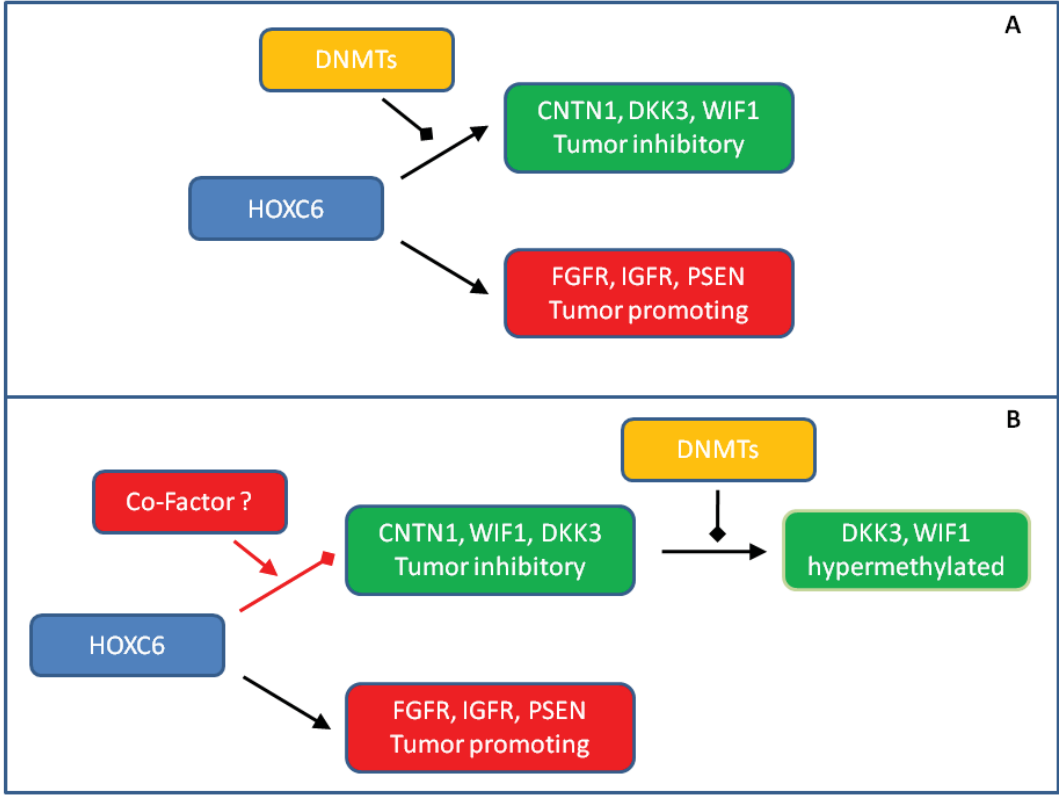
Figure 5. Hypotheses on the function of DNA methylation in inactivation of